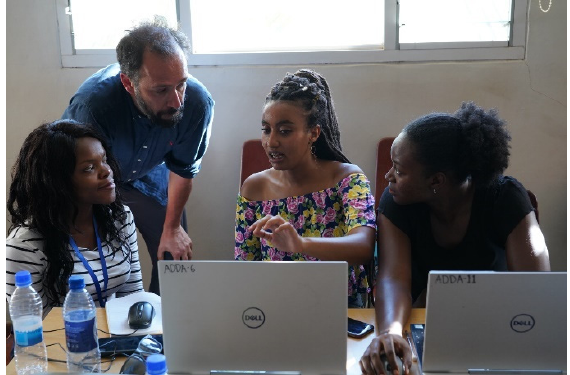
Figure 5. Training session during the ADDA workshop on the use of photogrammetry software.